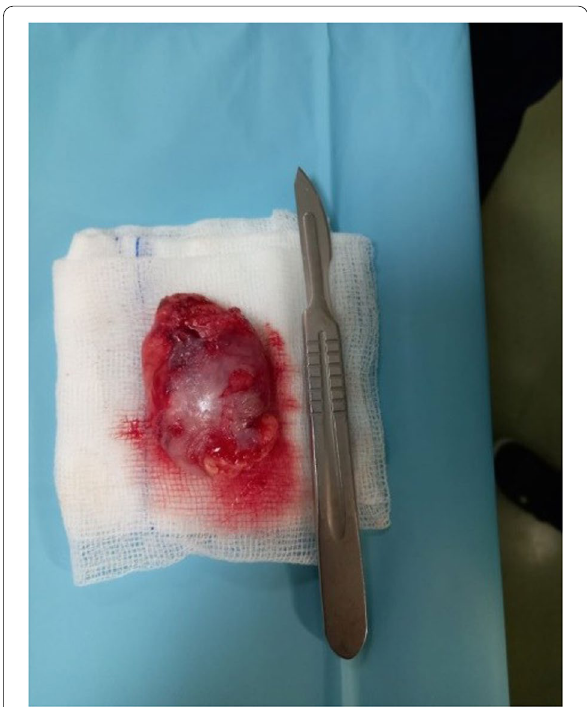
Fig. 3 Complete resection of the lipoma